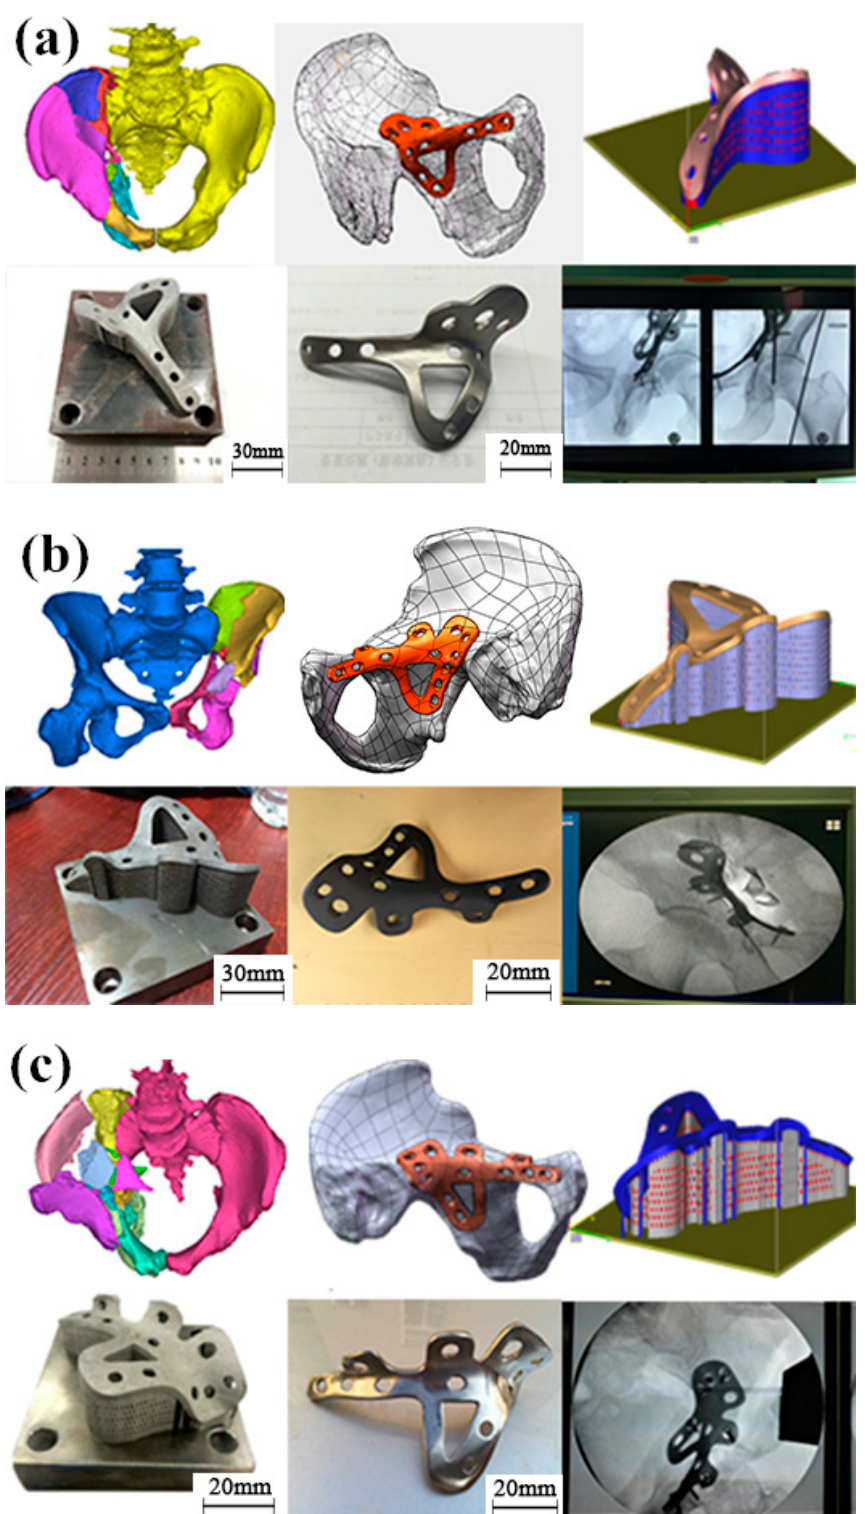
Figure 10. The other three successive clinical cases application process from design, metal 3D printing to clinical operation. ( a ) The second case; ( b ) The third case; ( c ) The fourth case.